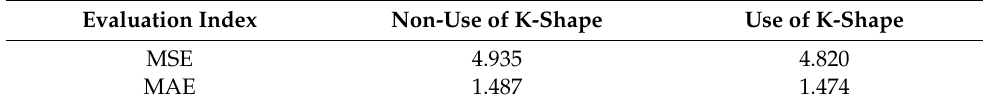
Table 9. Prediction accuracy before and after